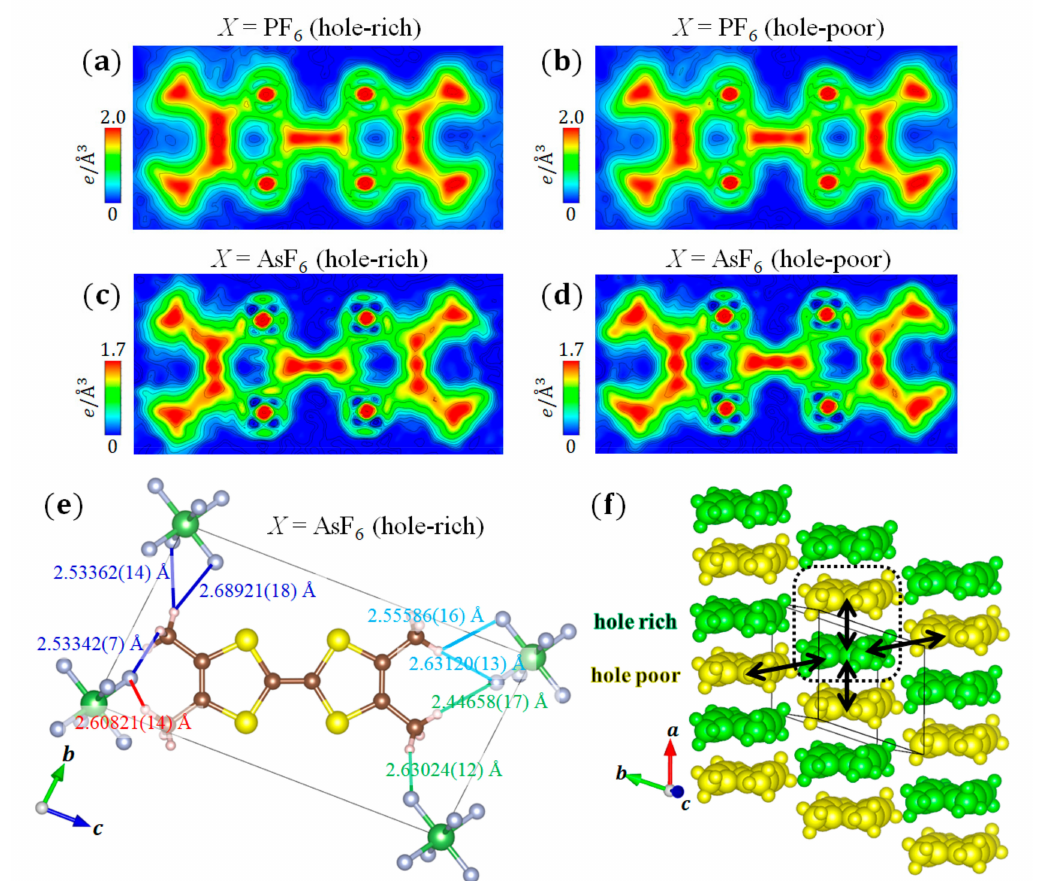
Figure 7. ( a – d ) VED distribution of hole-rich and hole-poor TMTTF molecules of (TMTTF) 2 PF 6 and (TMTTF) 2 AsF 6 on LS planes, respectively. The LS planes are defined by the central two C and four S atoms of the TMTTF molecules. ( e ) H–F distances of 2.7 Å or less in the hole-rich TMTTF molecule of (TMTTF) 2 AsF 6 . The orientations of the TMTTF molecules are the same between ( c , e ). ( f ) Charge ordering patterns of hole-rich and hole-poor TMTTF molecules in (TMTTF) 2 X ( X = PF 6 and AsF 6 ), which indicate a 2D Wigner crystal state. The region surrounded by the dotted square shows a TMTTF molecule